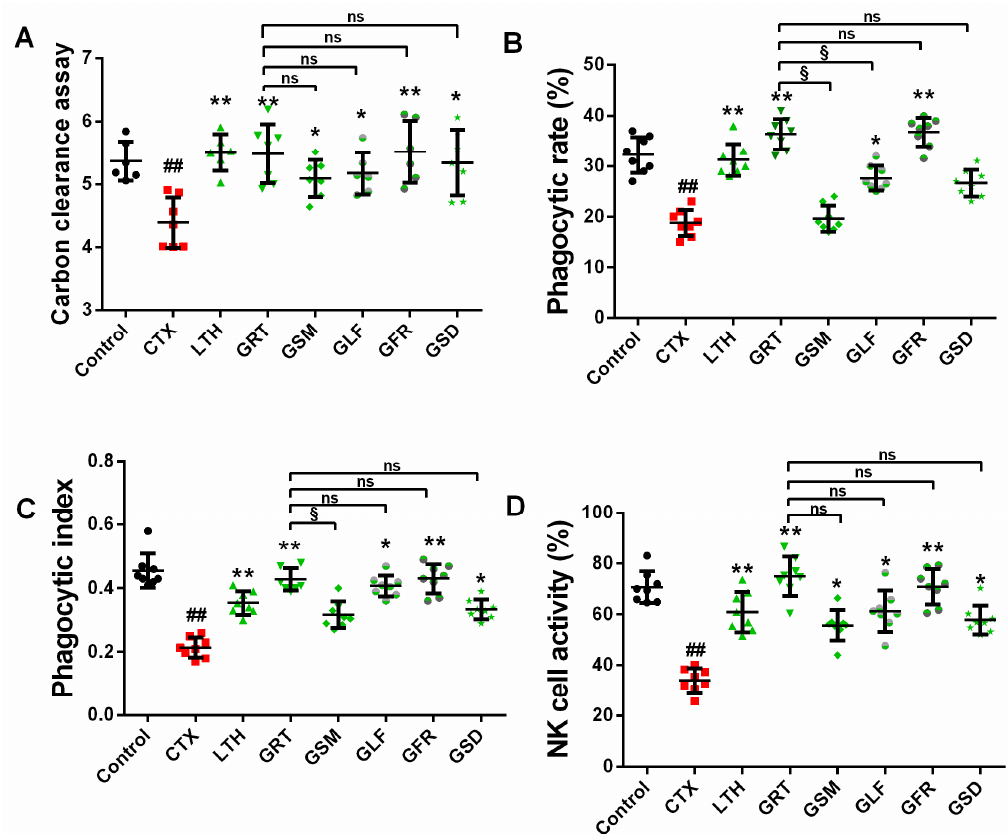
Figure 2. Effect of various parts of ginseng on the ( A ) carbon clearance assay; ( B ) phagocytic rate; ( C ) phagocytic index; and ( D ) NK cell activity. The values are presented as mean ± SD, n = 10. ## p < 0.01 compared with the control group. ** p < 0.01 and * p < 0.05 compared with the CTX group. § p < 0.05, ns p > 0.05 compared with the GRT group.